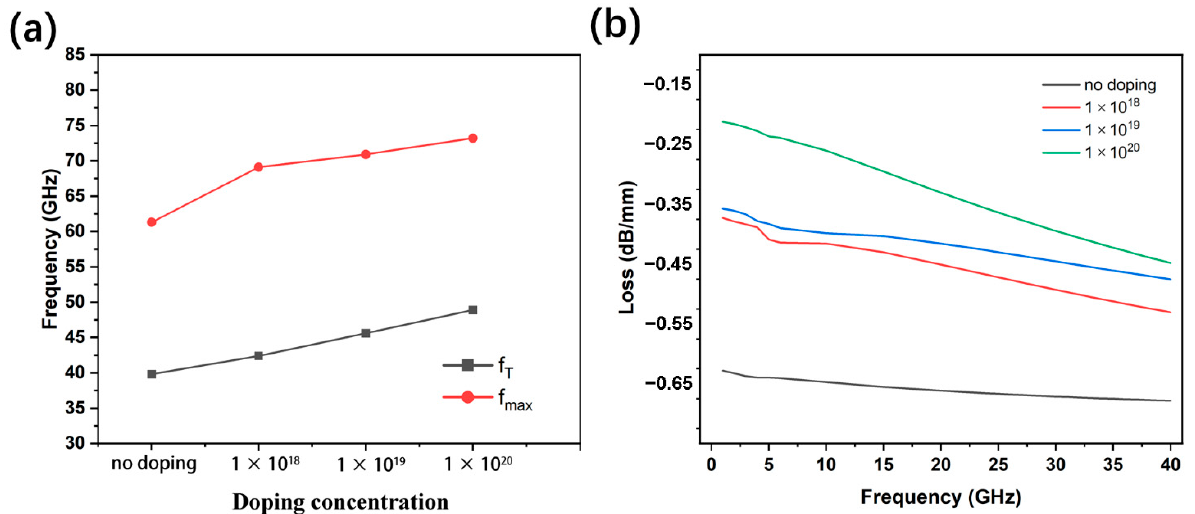
Figure 9. ( a ) f T and f max of the HEMT of AlGaN buffer layer with different doping concentrations; ( b ) The RF losses of the CPW with the HEMT of AlGaN buffer layer with different doping concentra- tions.